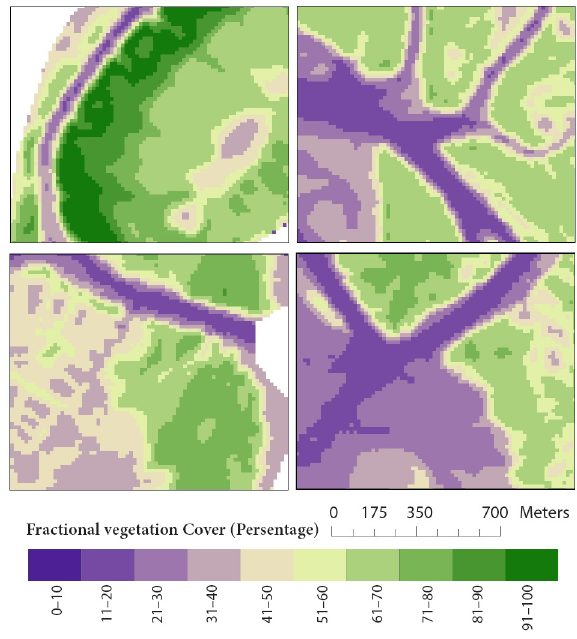
Figure 6. Display of discrete fraction vegetation cover Fuzzy borders’ displays with methods shown in Fig- ures 5 and 6 can be used to display a fuzzy phenomenon using a raster-based method. But if we want to display more of a fuzzy phenomenon, or fuzzy areas altogether, another solution will be needed. One of these solutions is using the theory of additive colors mixing. In this theory, all colors are created by combining the three primary